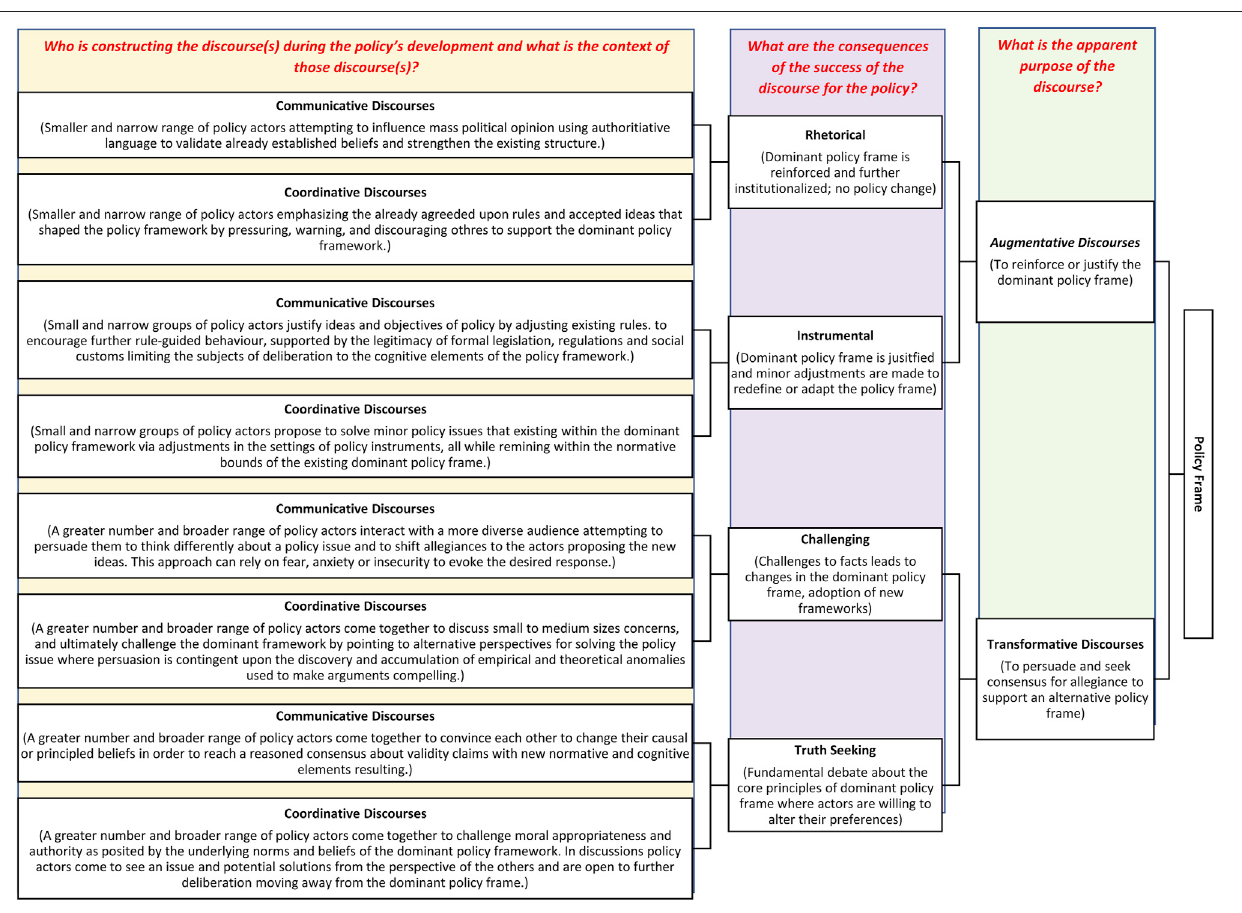
FIGURE 1 | Methodological framework for analyzing communicative and coordinative discourses and policy change.